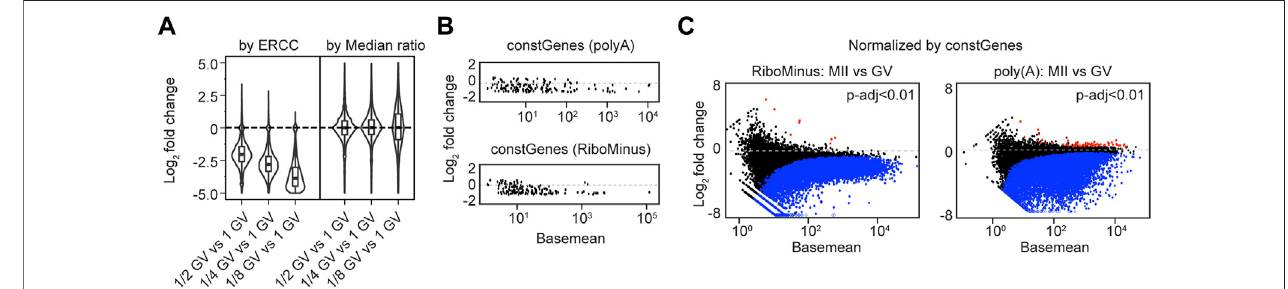
FIGURE5| Applyingconstantgenes(constGenes)forcross-stagecomparison. (A) Summariesoflog 2 foldchangevaluesinfractional(1/2,1/4,1/8)GVoocytevs. 1 GV oocyte by ERCC normalization and median ratio normalization. (B) MA plots of selected 147 constant genes (constGenes) from poly (A) and RiboMinus RNA-seq results. (C) MAplots showingthe differentially expressed genes(MII vs. GV)from RiboMinus RNA-seq andpoly (A)RNA-seq,normalized byconstGenes.Blue/reddots: genes having decreased/increased abundance by P -adjusted <